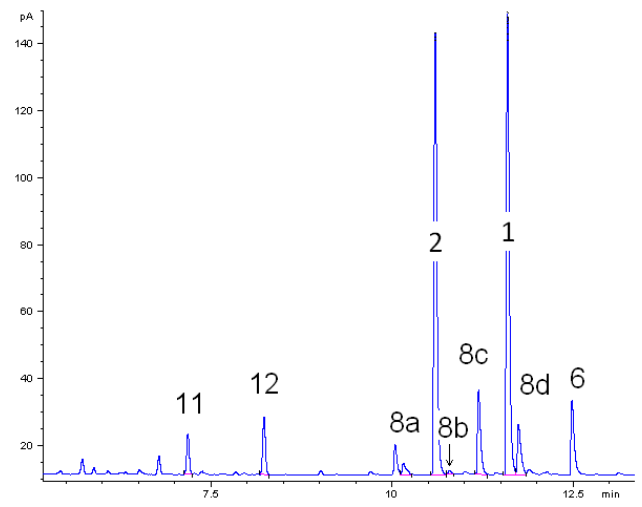
Figure 2. Gas chromatogram (GC-FID) of the liquid pyrolysis products of cis